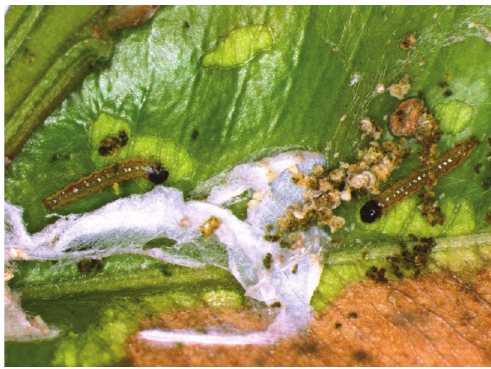
FIGURE 4. Adult of box tree moth (photo György Csoka)